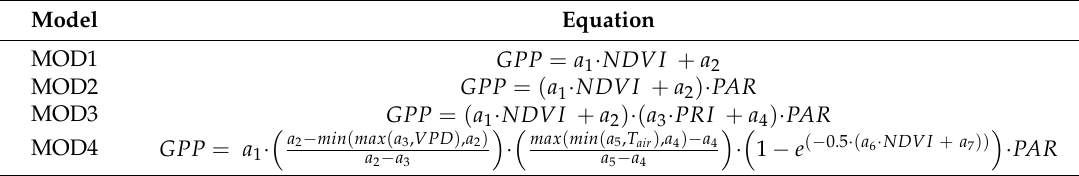
Table 2. Optically-based Gross Primary Production ( GPP ) parametric models inverted against observed half-hourly GPP ( GPP hh ) and micro-meteorological